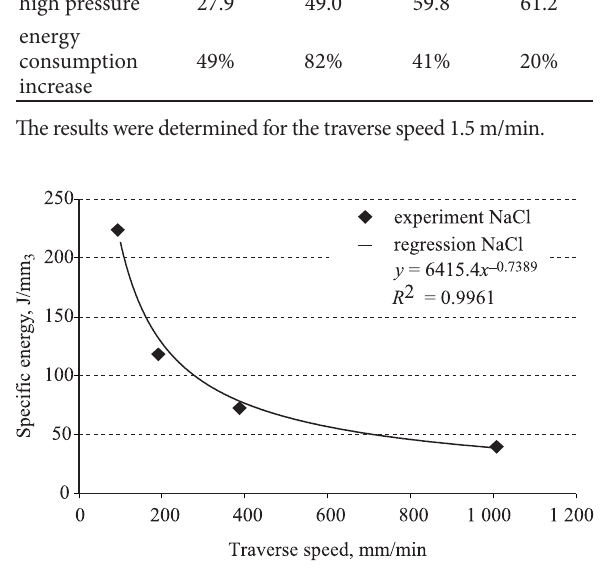
Fig. 5. Trend of the specific energy respective to traverse speed for concrete samples stored in NaCl lotion